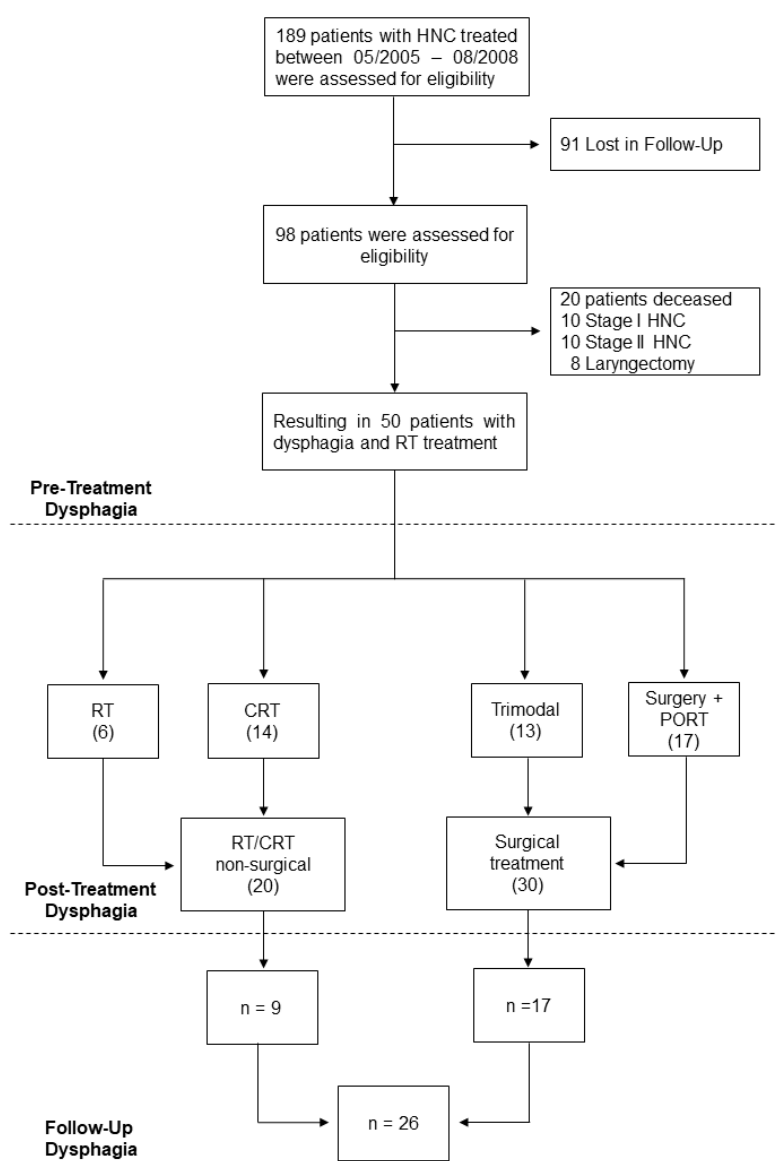
Figure 1. Flow-Chart. Time period in figure refers to May 2005–August 2008. The number in brackets refer to quantity of patients included in each group. Abbreviations: CRT, chemoradiotherapy; HNC, Head and Neck Cancer; PORT, post-operative radiotherapy; RT, radiotherapy.